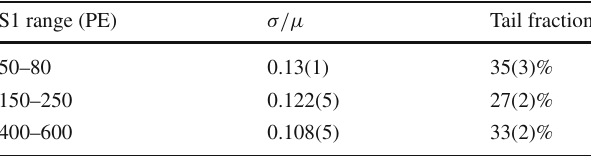
Table 1 Relative standard deviation ( σ/μ ) and tail fraction from the fits of Fig. 15. The tail fraction is defined as the fraction of events outside the interval μ ± 1 . 96 σ , which corresponds to the 90% quantile of a Gaussian distribution. The significant fraction of events in the tails is due to a non-Gaussian S2 response, leakage from ER events, and pile-up. Only statistical uncertainties are reported